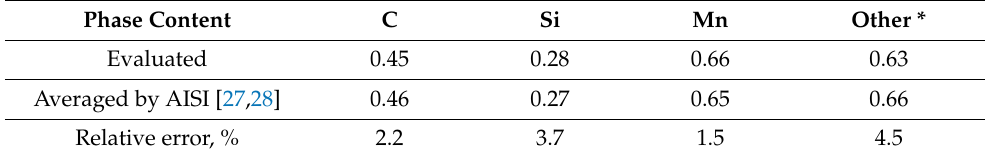
Table 3. The test accuracy for steel AISI